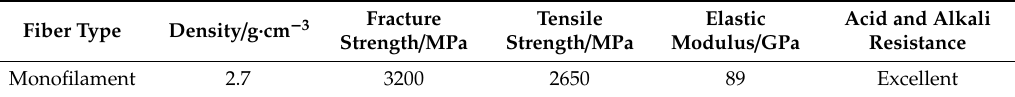
Figure 1. Basalt fibers and tailings particles. Table 1. Technical specifications of the basalt fibers [37].